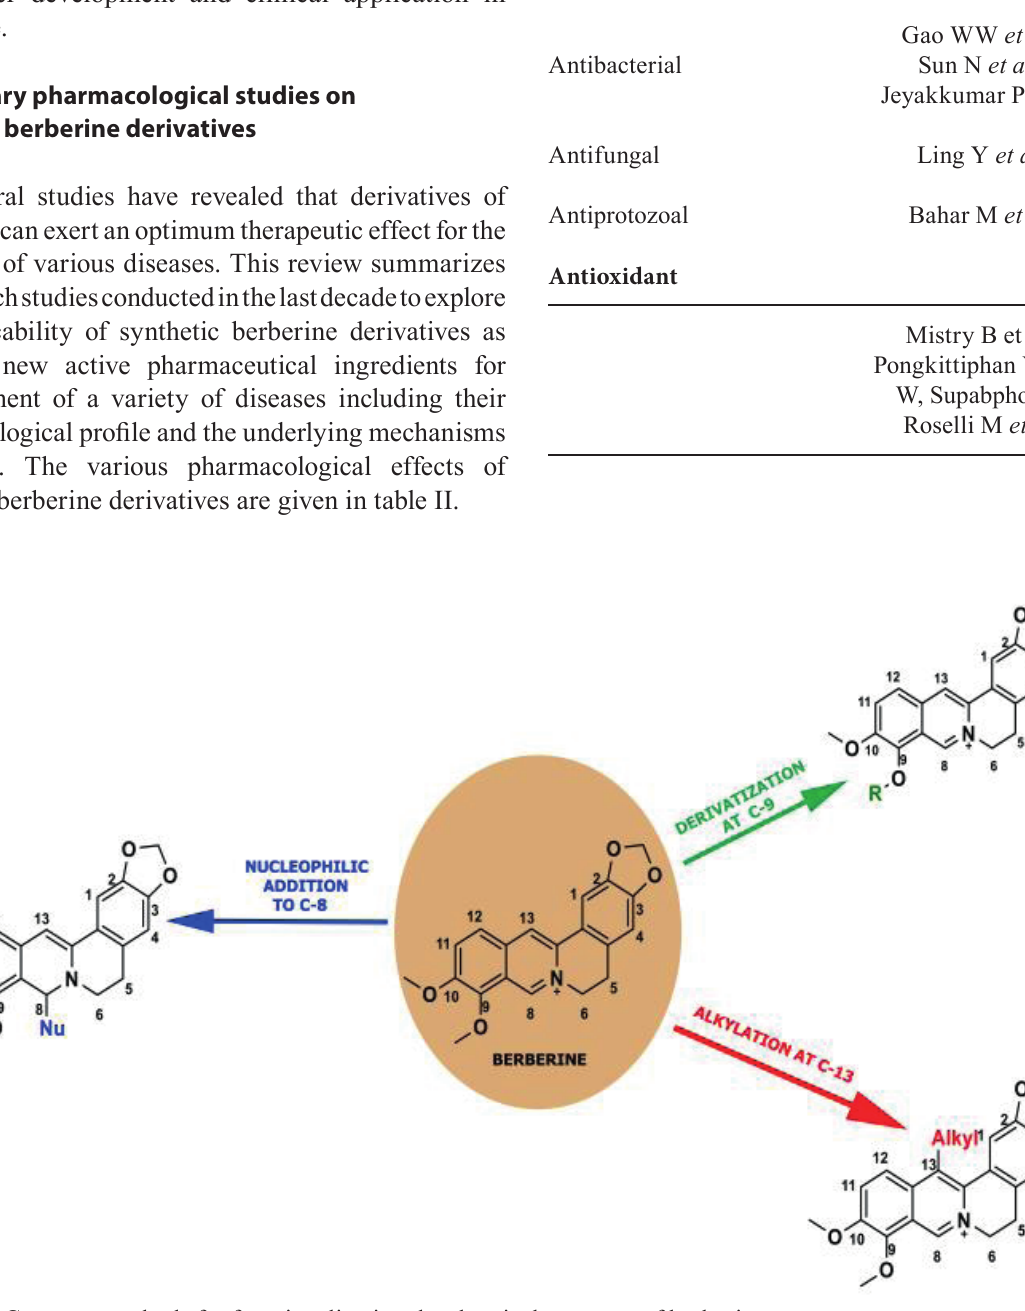
FIGURE 5 - Common methods for functionalization the chemical structure of